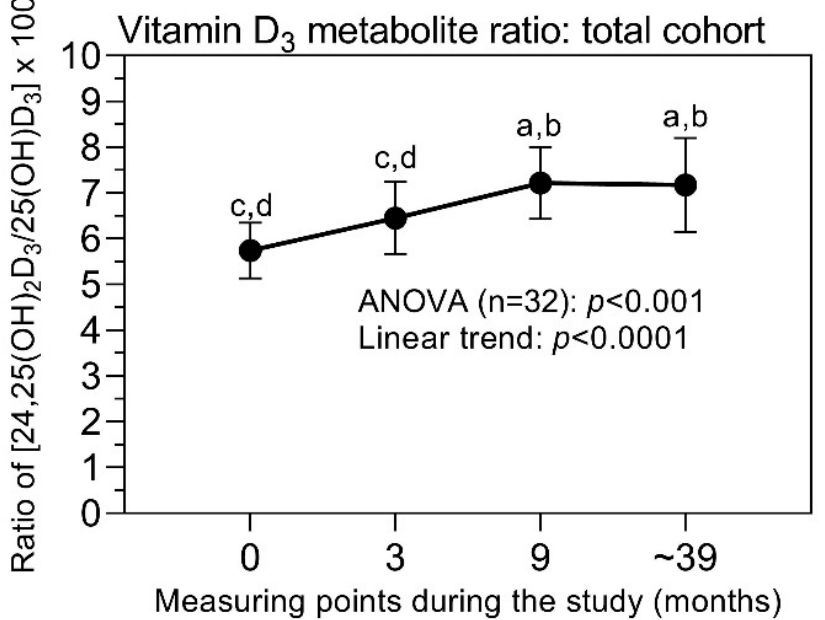
Figure 5. Change in the vitamin D 3 metabolite ratio (VMR) in the total cohort during the study. The ratio [24,25(OH) 2 D 3 to 25(OH)D 3 × 100] defined as vitamin D 3 metabolite ratio increased during the study. Data at the time points are mean values with their 95% confidence intervals. At the error